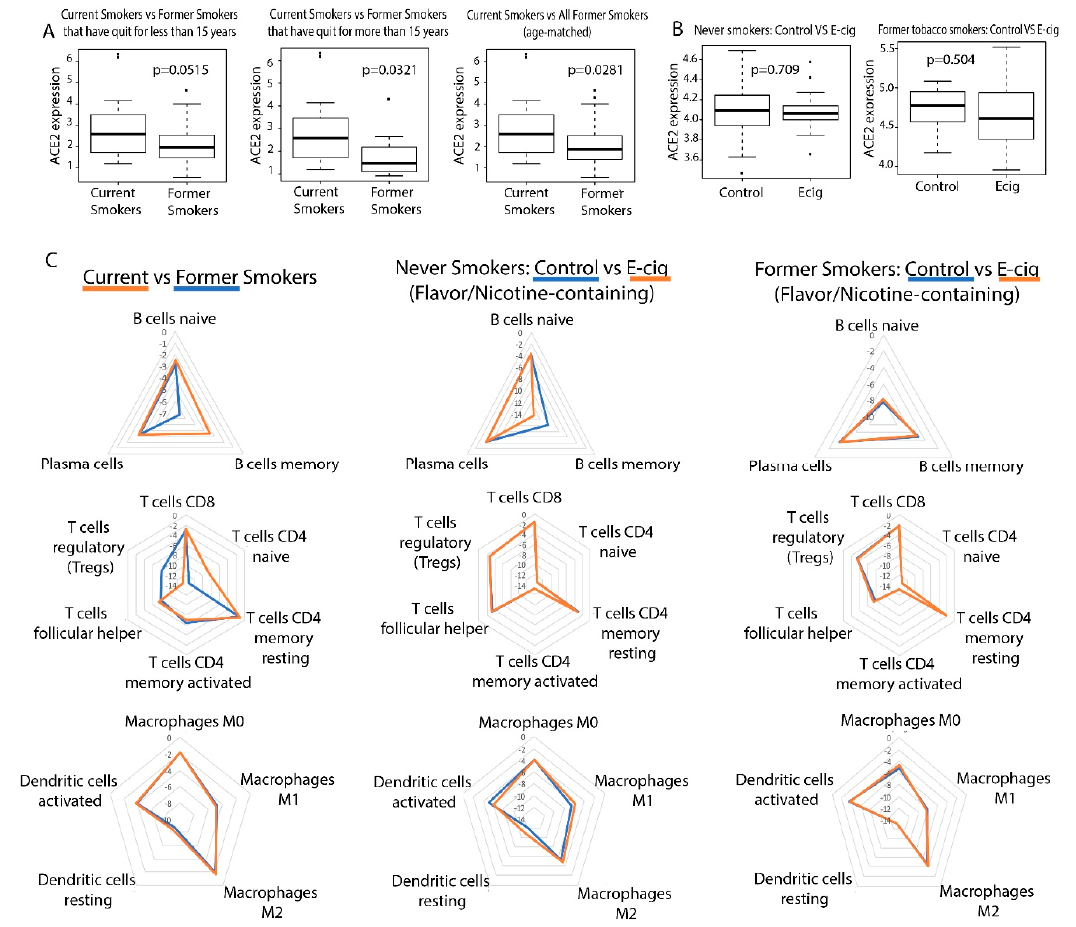
Figure 1. ACE2 and general immune dysregulation analysis in tobacco and electronic cigarette (e-cig) users. ( A ) Boxplots of ACE2 expression in current and former smokers, including those that have quit for less than and more than 15 years. ( B ) Boxplots of ACE2 expression in control and e-cigarette users, including patients who have never smoked tobacco and those who are former tobacco smokers. ( C ) Radar plots comparing immune cell infiltration across smokers, e-cigarette users vaping nicotine-less, flavor-less e-cigs, and vapers who used e-cigs containing nicotine and flavors. Greater immune cell infiltration is indicated by a value closer to zero and farther away from the center of the radar